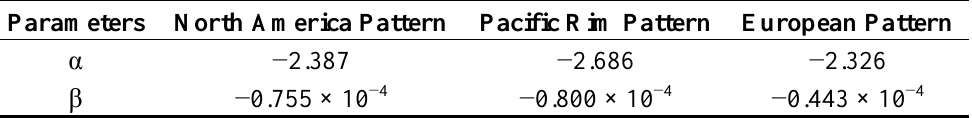
Table 4. The results of curvature parameter estimation.